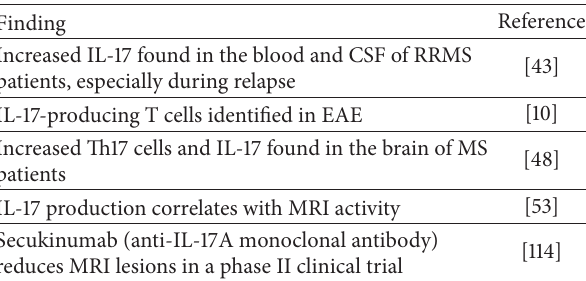
Table 1: Hallmarks on the understanding of the role of the Th17 pathways in